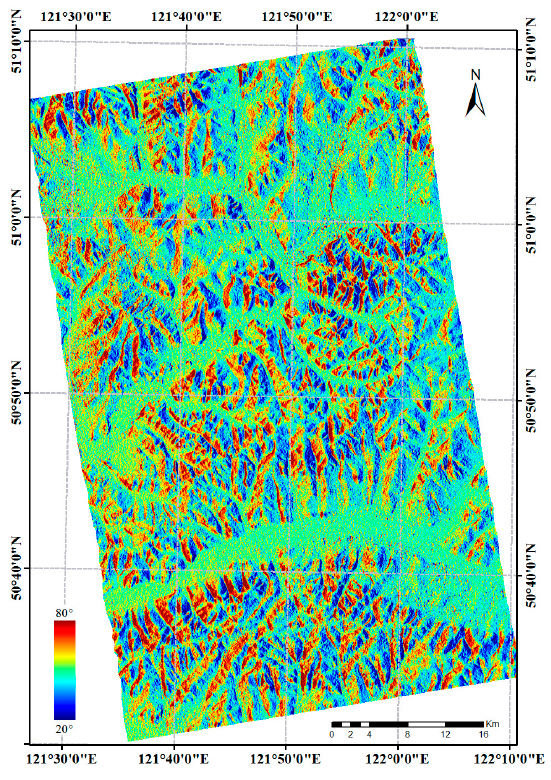
Figure 10. Projection angle ψ .